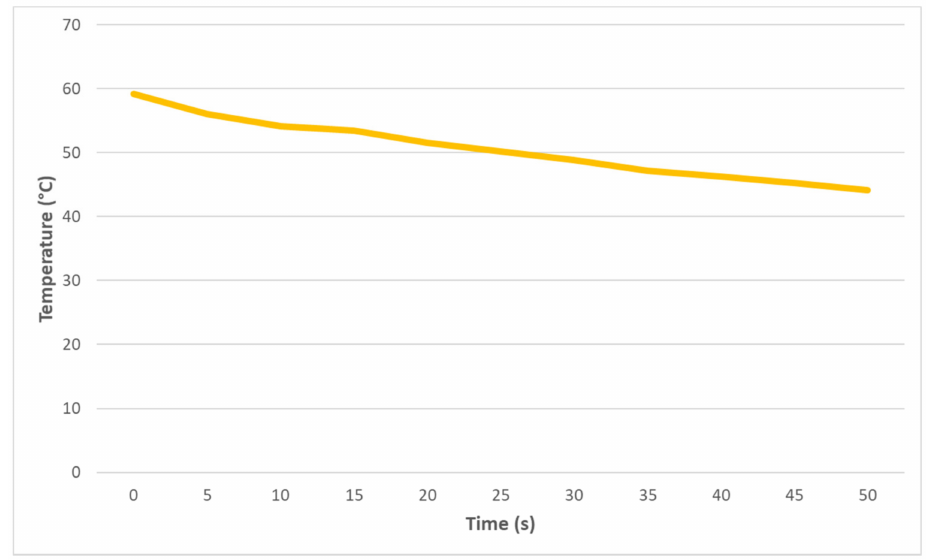
Figure 8. ( a ) WTB sample for inspection and the delamination defects at subsurface circled in red; ( b ) Heat gun for loading the blade surface.